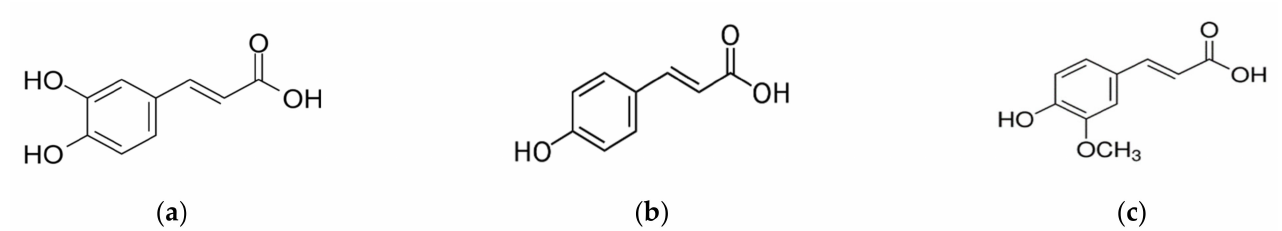
Figure 1. Structure of caffeic acid ( a ), p-coumaric acid ( b ) and trans-ferulic acid ( c